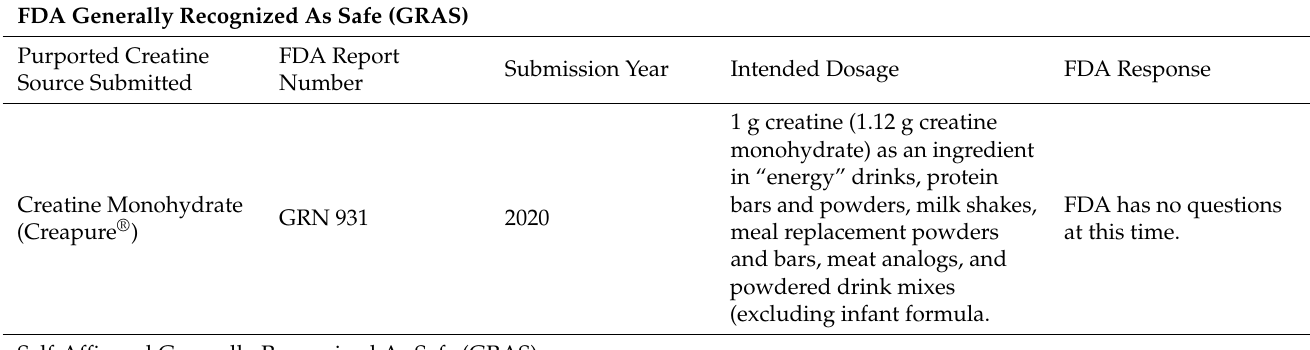
Table 5. Regulatory status of nutrients marketed as creatine supplements in the United States of